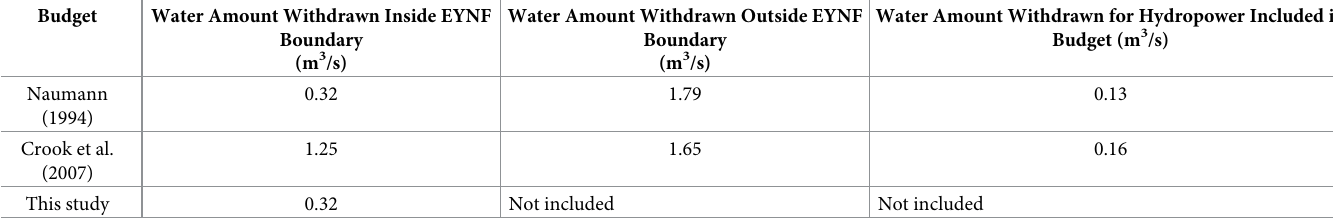
Table 4. Comparison of water withdrawn inside and outside of the EYNF Boundary across